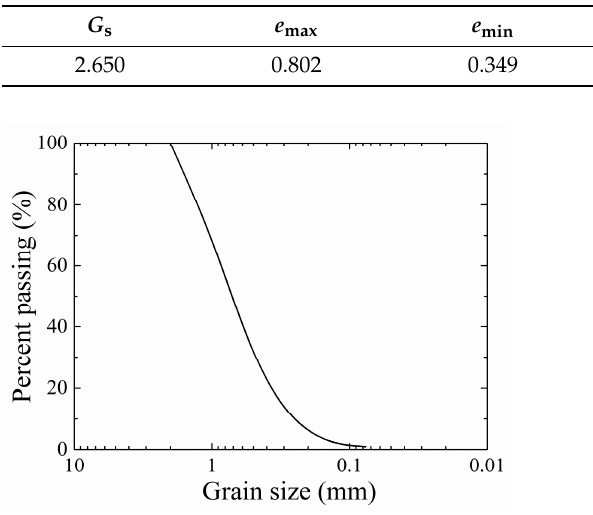
Table 1. Physical parameters of the test sand.